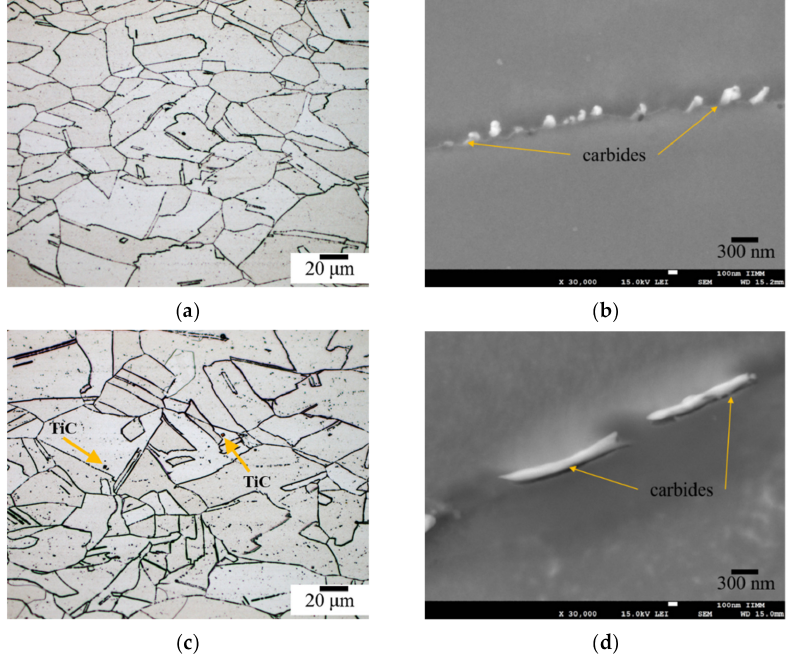
Figure 2. Microstructure of IN600 ( a , b ) AR and ( c , d ) HT at 700 ◦ C for 300